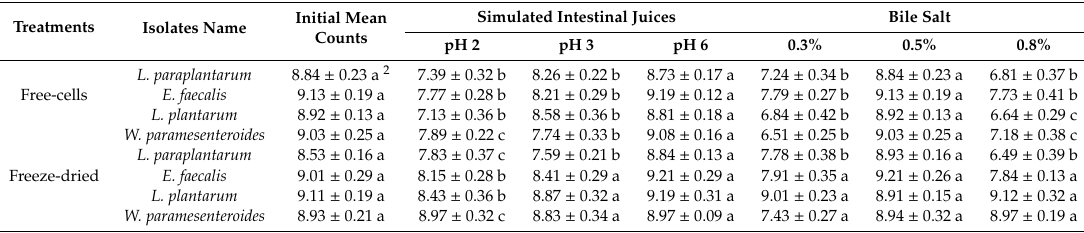
Table 2. Comparison of free and freeze-dried bacteria counts in simulated intestinal juices and bile salt conditions after